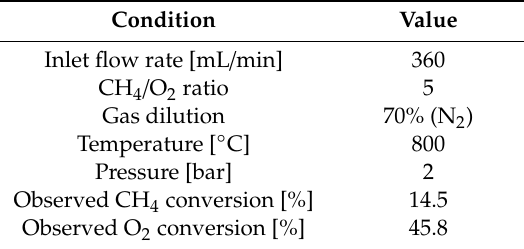
Table 2. Conditions and performance parameters of the standard experiment used for mass and heat transfer calculations.